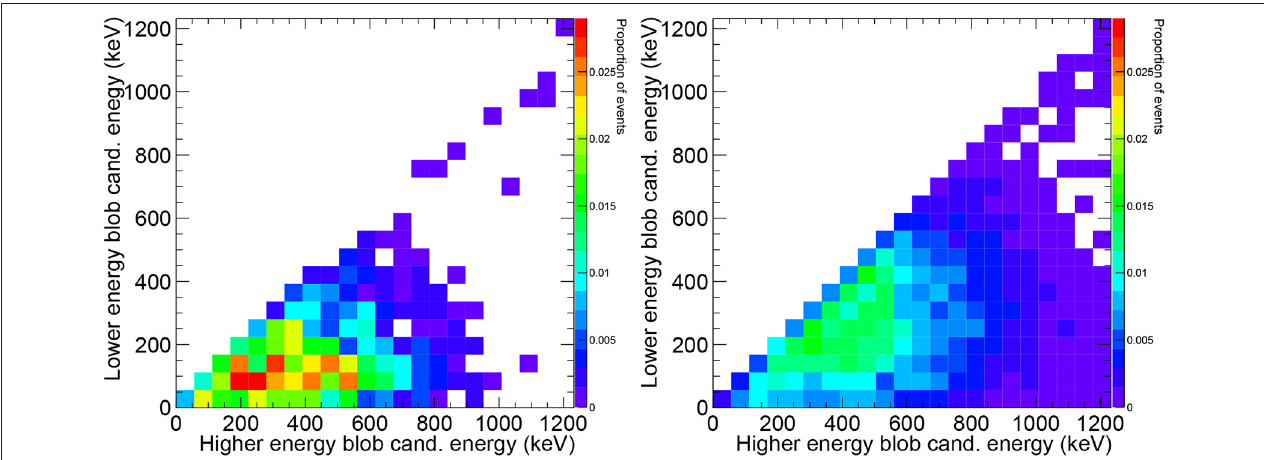
FIGURE 7 | Energy distribution of the blobs at the end-point of single electrons coming from 22 NA decays (Left) and tracks (mostly electron-positron pairs) coming from the 208 Tl double escape peak (Right) . Figure from Ferrario et al.